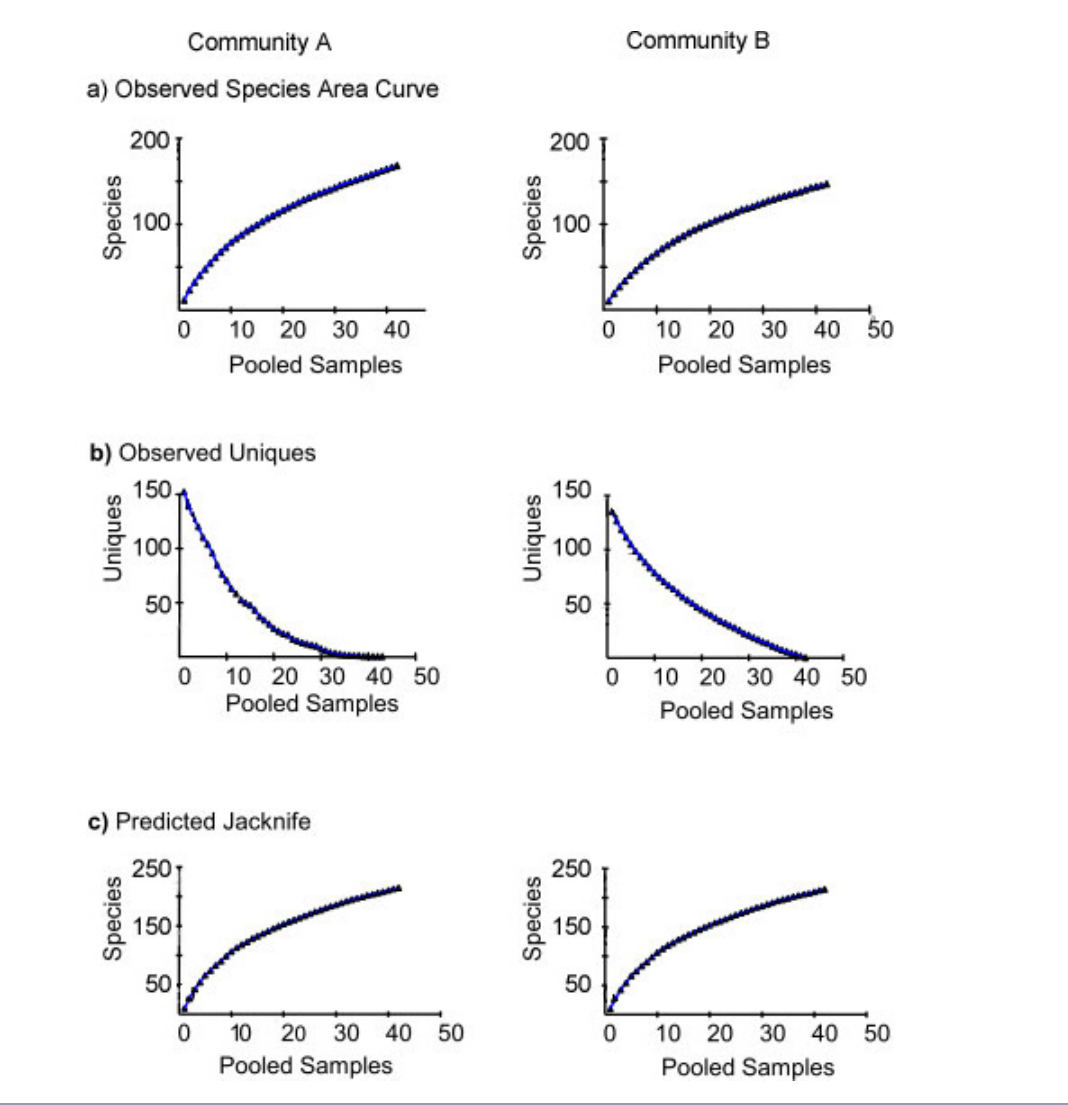
Fig. 3. Observations and estimates of species richness in two